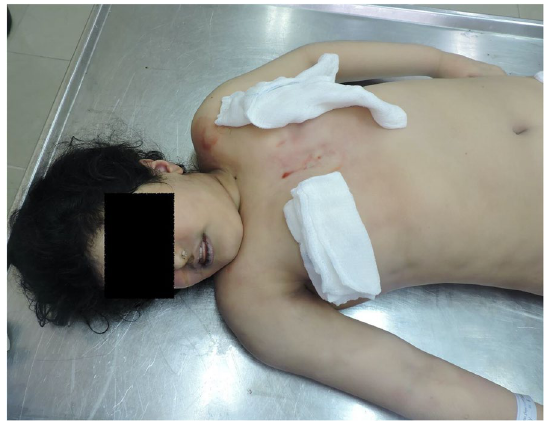
Fig. 2 Contusion over the mid of the chest, indicating medical